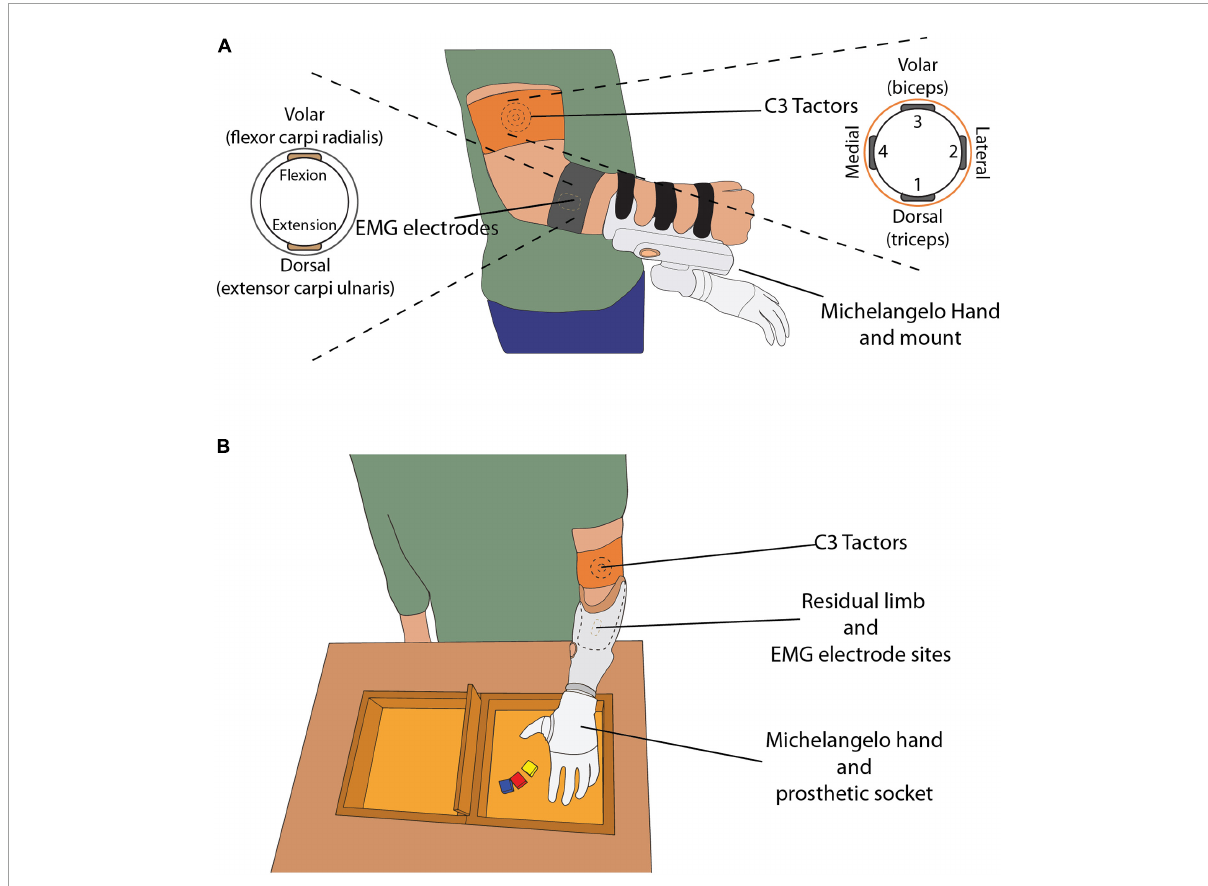
FIGURE1 (A) The able-bodied subject wearing C3 tactors, EMG electrodes and the mount with the Michelangelo hand attached. The drawings on the left and right display the placement of the electrodes and tactors around the subject’s arm, respectively. (B) The amputee subject wearing the custom-made socket, with the EMG electrodes embedded in the socket, and C3 tactors placed on their left upper arm. The box and blocks setup is placed on the table in front of the subject.